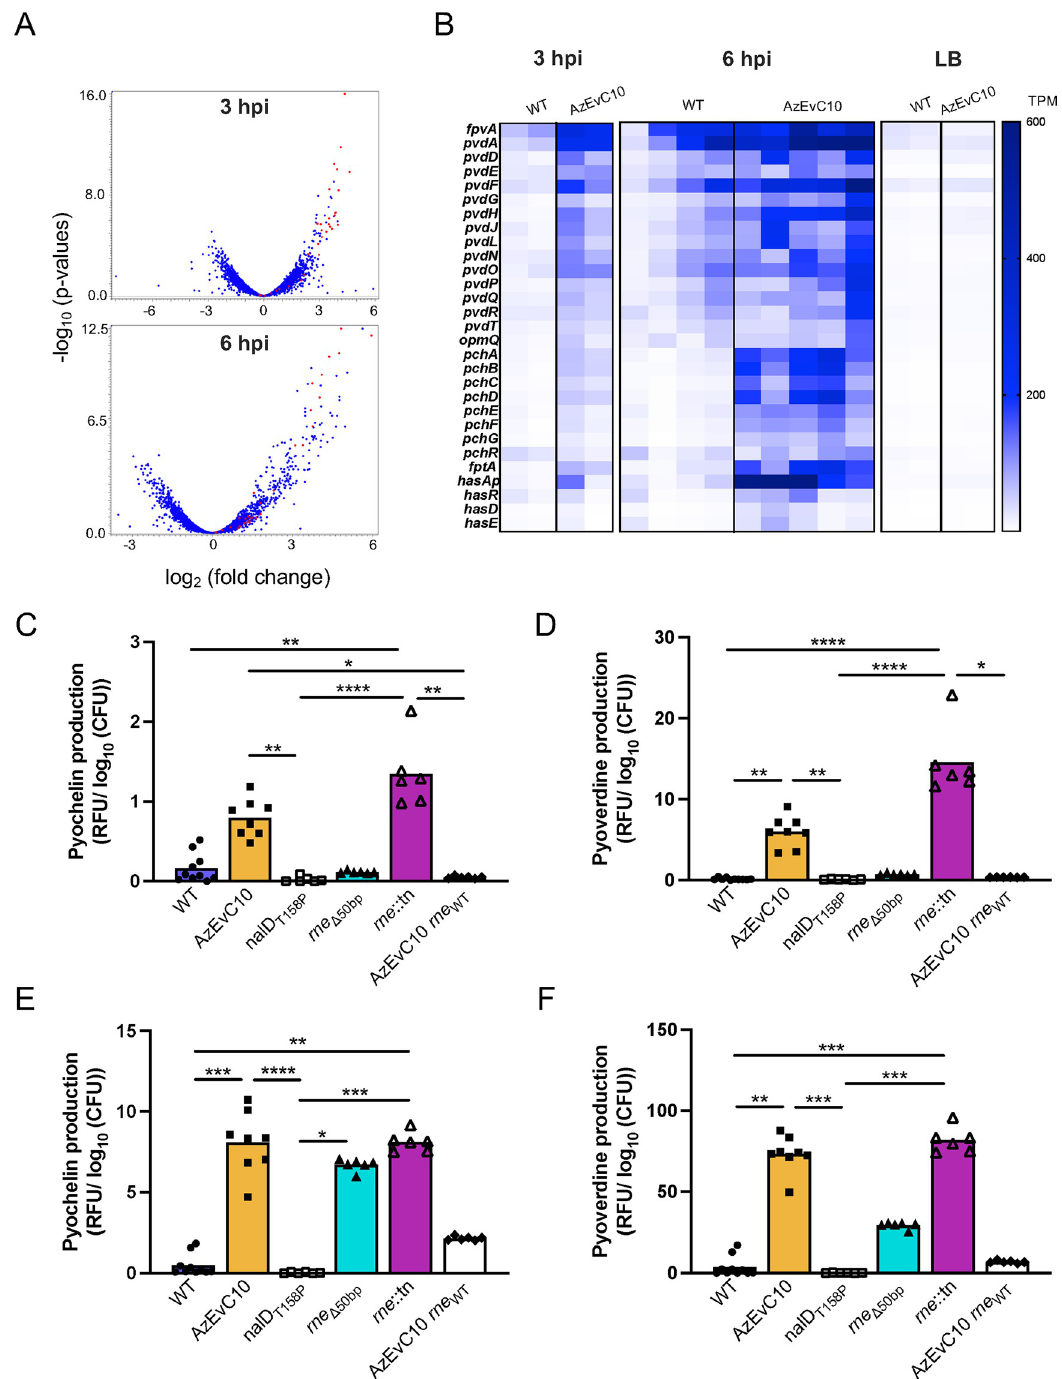
Fig 3. Iron acquisition genes are upregulated in the AzEvC10 mutant during macrophage infection. A-B. Genes involved in iron acquisition were upregulated in the AzEvC10 mutant compared to WT PAO1 during BMDM infection at 3 hpi (n = 2) and 6 hpi (n = 4–5), but not when grown in LB broth (n = 2). A . Volcano plot highlighting differentially expressed iron acquisition genes in red during BMDM infection. B . Heat map indicates expression of indicated genes in individual biological replicates expressed in normalized number of reads (TPM) during WT and AzEvC10 BMDM infections at indicated time points. C-F. Pyochelin and pyoverdine production by given strains measured by fluorescence (Ex350/Em430 for pyochelin and Ex400/Em460 for pyoverdine) at 3 hpi (C-D) and 6 hpi (E-F) and normalized to log 10 (CFU). n = 5–8 independent replicates for each experiment. * p < 0.05, ** p < 0.01, *** p < 0.001, **** p < 0.0001. See S5 Table for statistical tests used and exact p -values.